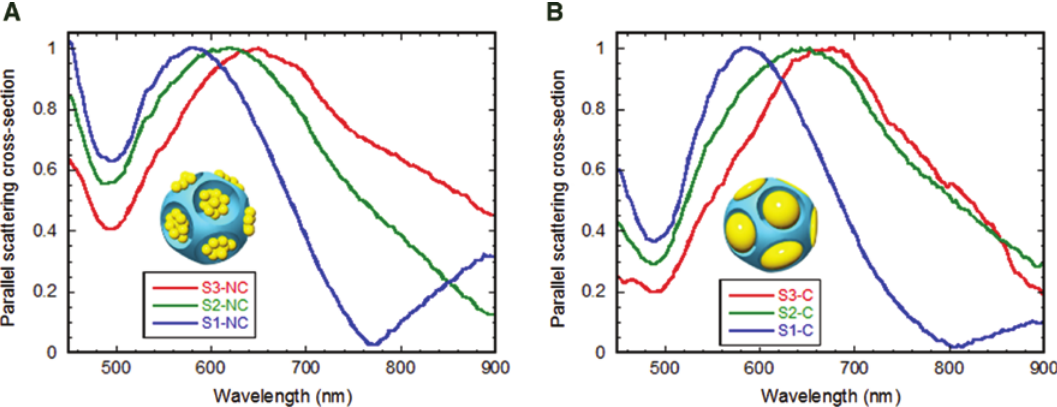
Figure 7: Measured parallel scattering cross-sections of uncondensed and condensed dodecapods. MD EQ [Eq. (5), maximum normalized to 1] of the dodecapod samples before (A) and after (B) annealing. The Parallel scattering cross-section σ + // resonant response red-shifts with increasing gold load. Annealing sharpens the resonance with very slight red-shift in wavelength.